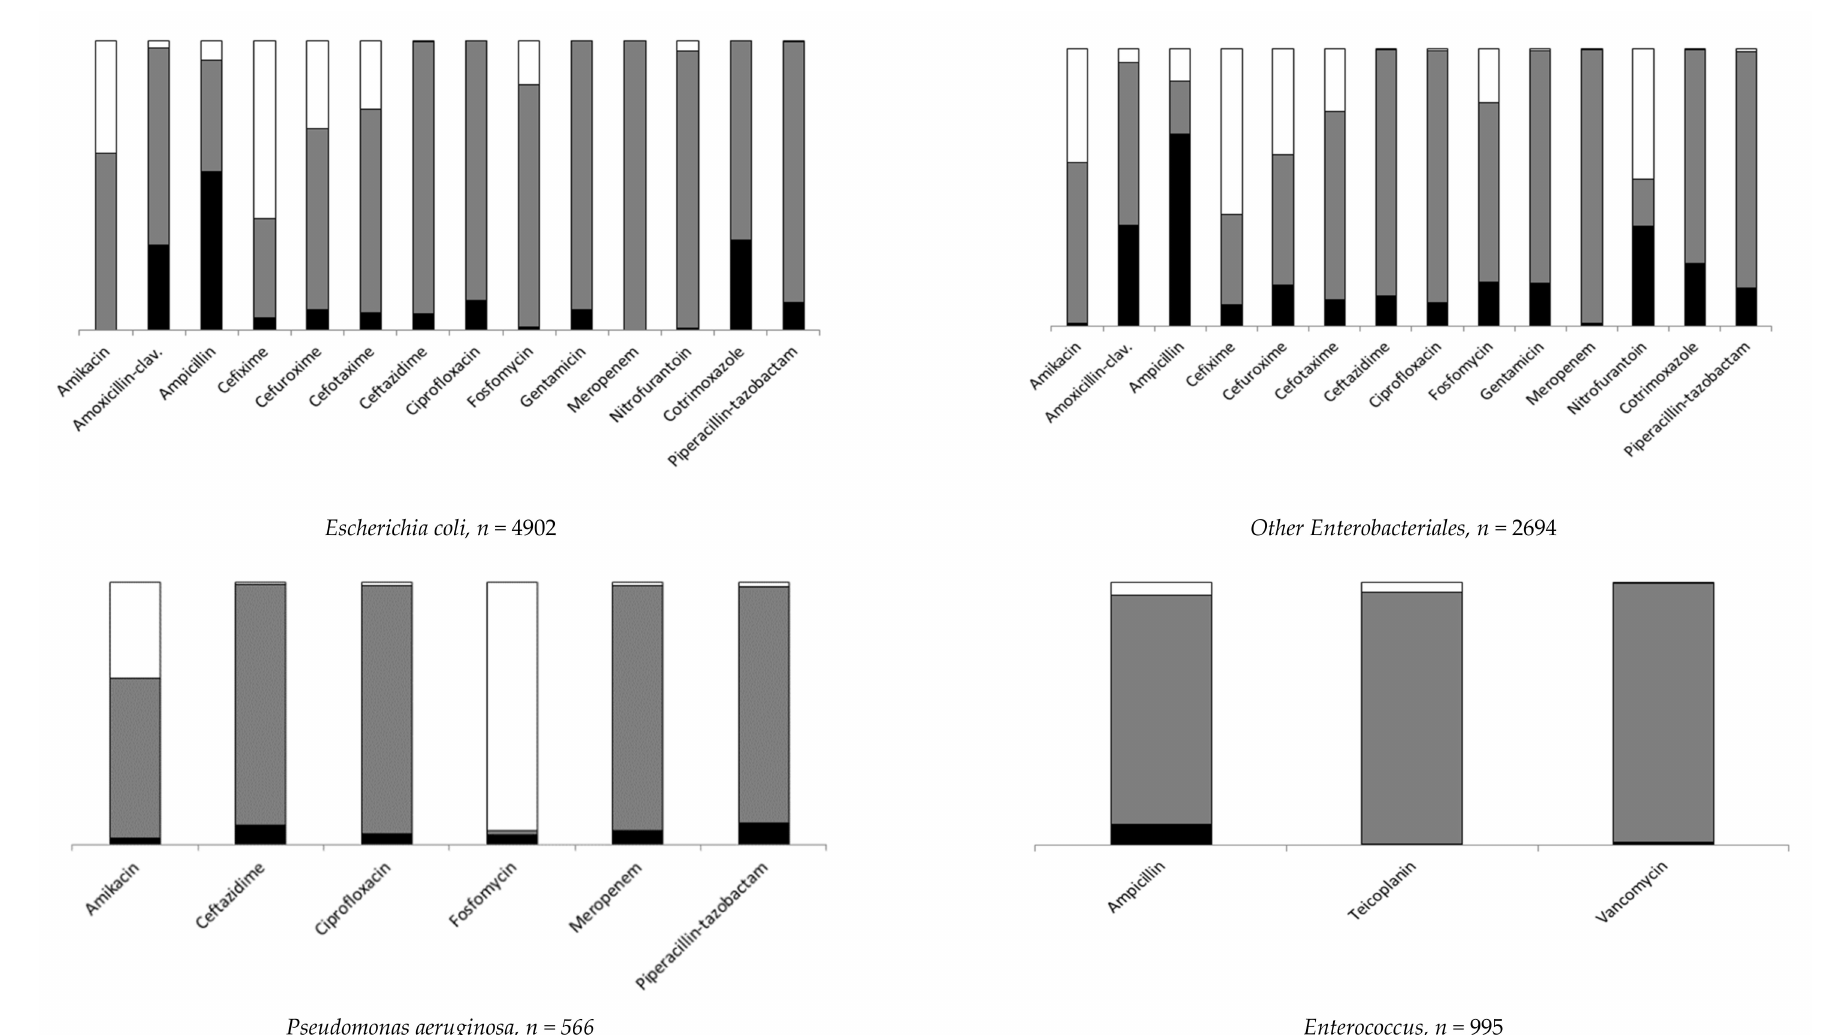
Figure 2. Distribution of antibiotic resistant strains (details in Supplementary Table S3). A black box represents the percentage of resistant, a gray box the percentage of susceptible and a white box the percentage of not